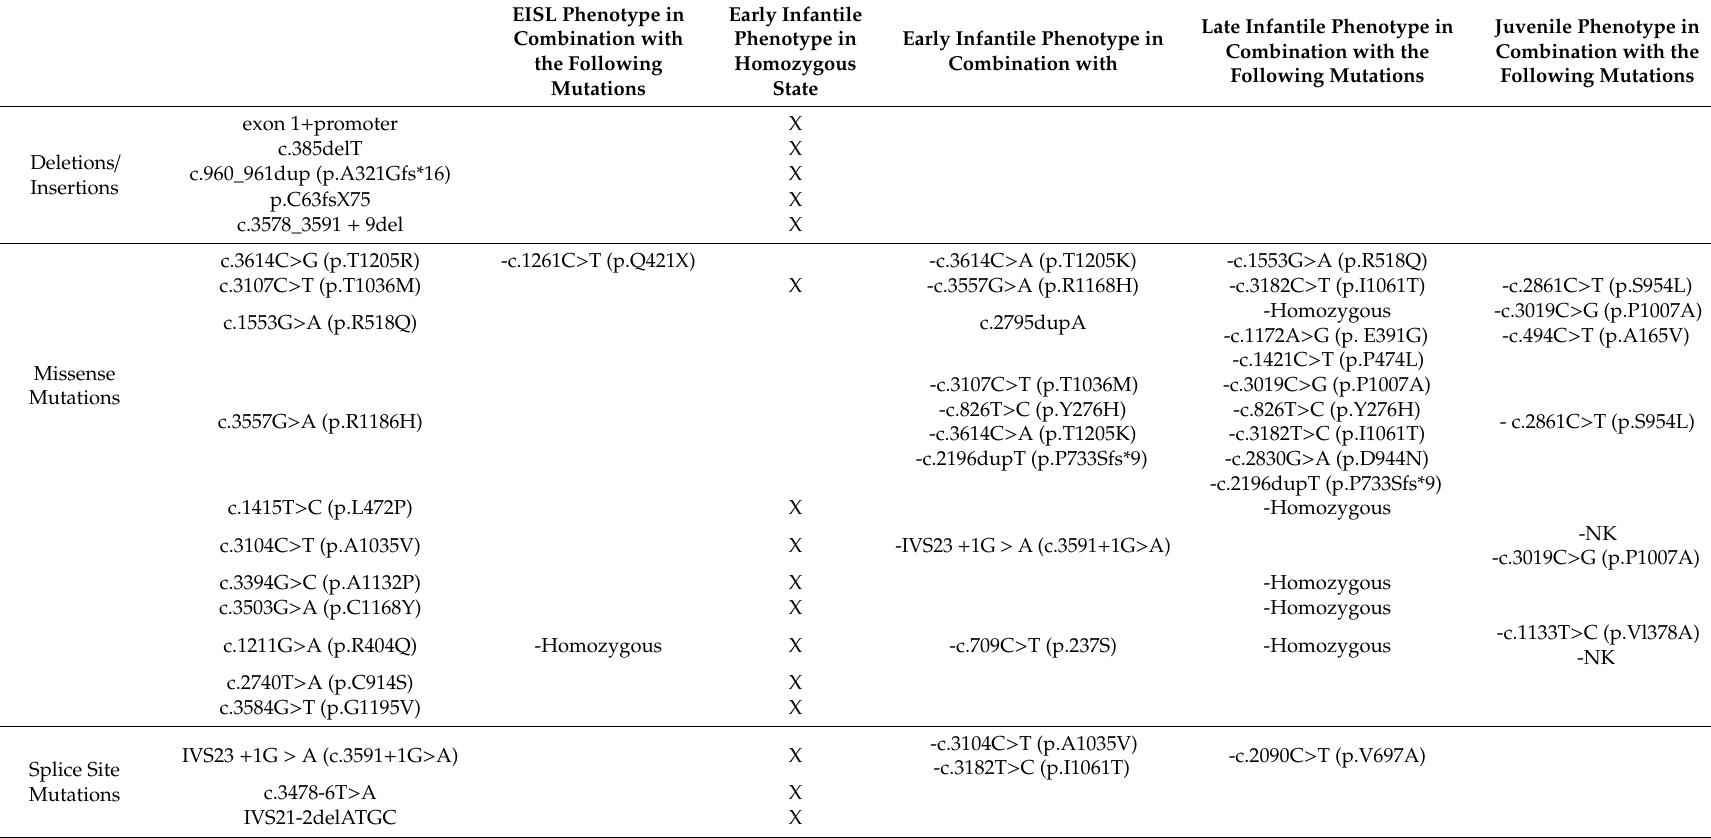
Table 4. NPC1 mutations causing early infantile phenotype. Mutation–phenotype